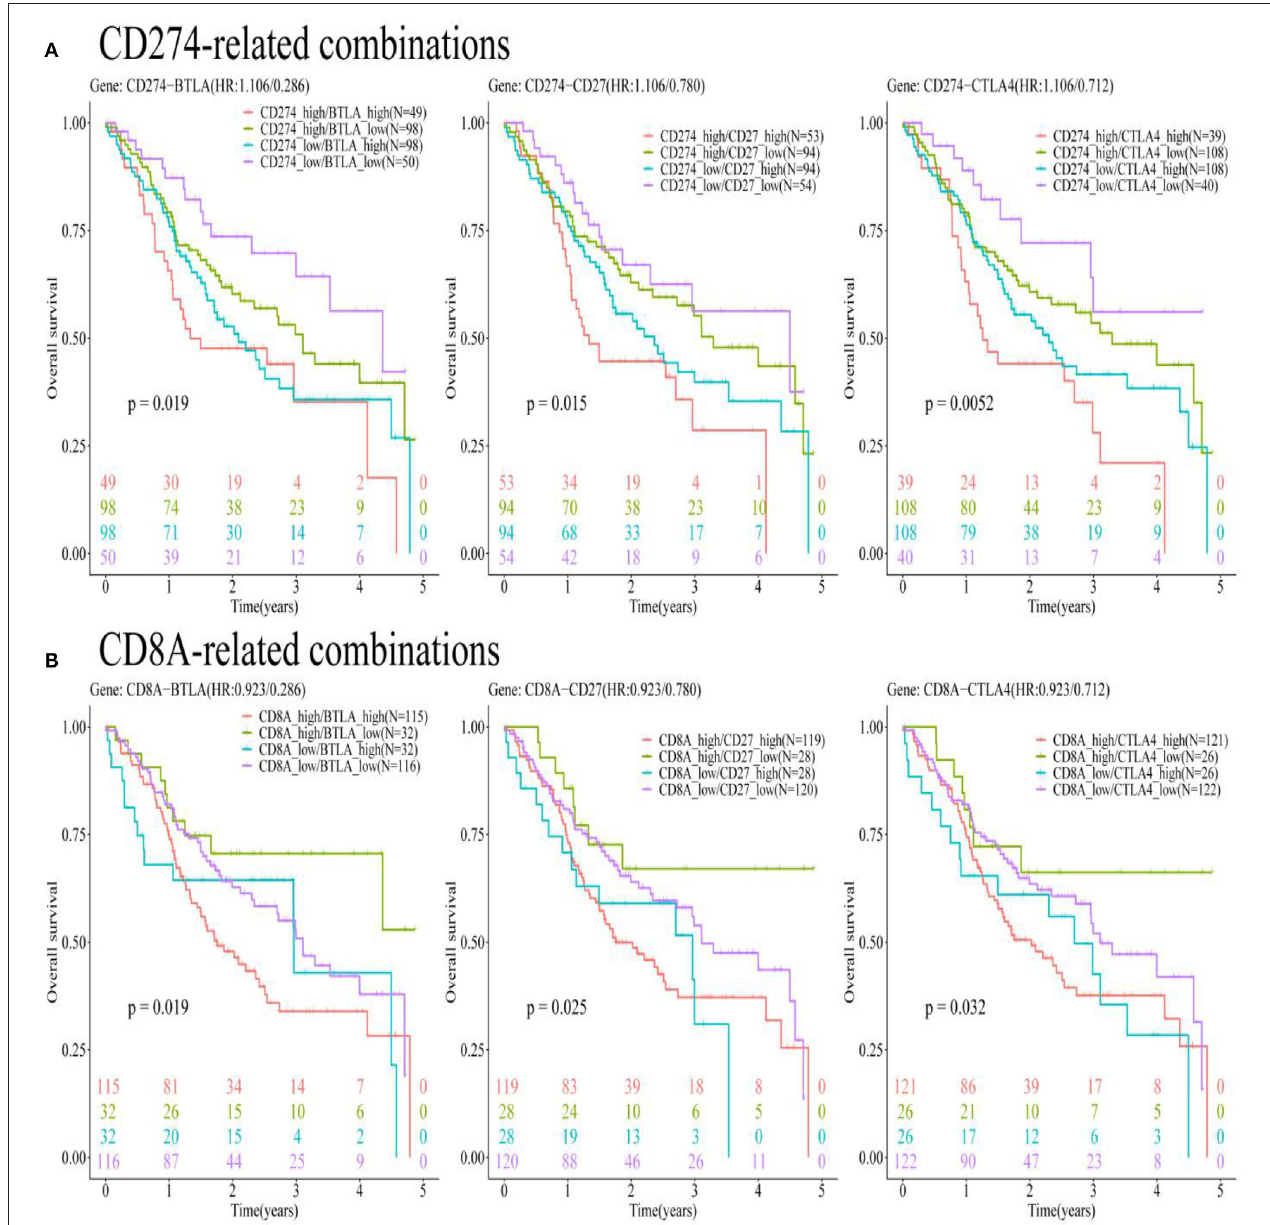
FIGURE 9 | The KM plots show a significant relationship between the 5-year OS and gene pairs subtypes consisted of CD274-related genes, based on the TCGA-OSCC data analysis. (A) The KM plots show the prognostic values of subtypes consisted of CD274 and its positively correlated ICGs (BTLA, CD27, and CTLA4). (B) The KM plots show the prognostic values of CD8A and three ICGs positively correlated with CD274 (BTLA, CD27, and CTLA4). T-cells (51–53). Patients with lung cancer negative for both